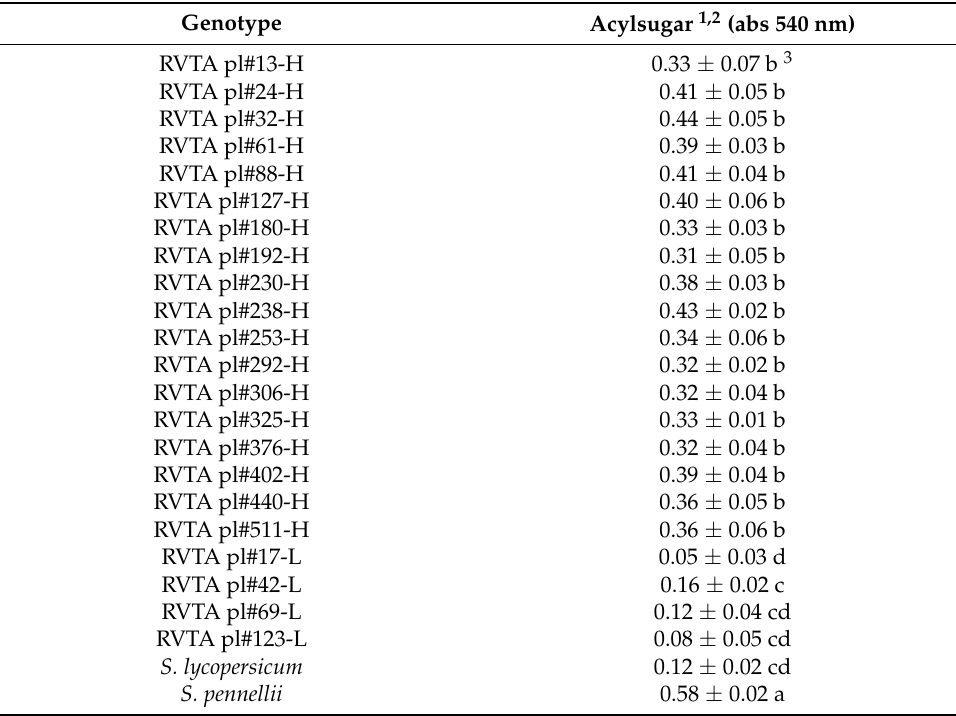
Table 3. Mean ( ± standard deviation) values of acylsugar contents at 540 nm levels obtained from contrasting F 2 BC 3 genotypes (H = high content and L = low